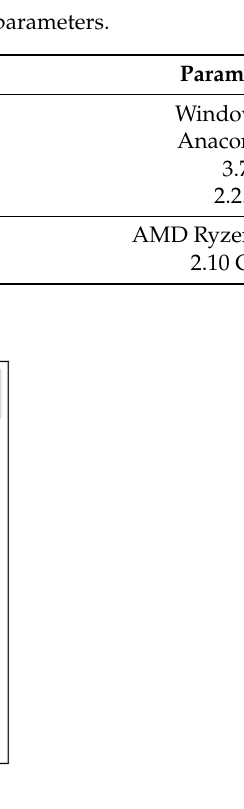
Figure 7. The variation diagram for training loss and verification loss. Table 3. Software and hardware environment experiment parameters.